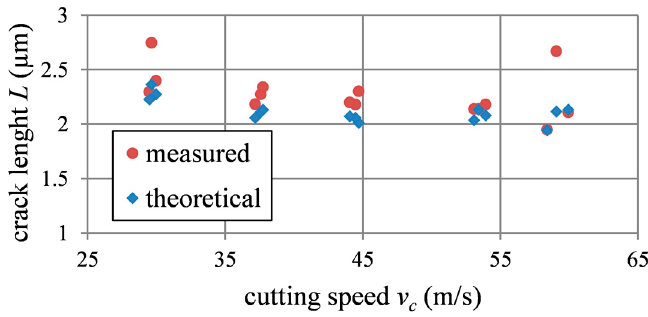
Figure 13. Measured and calculated crack length for different cutting speeds.